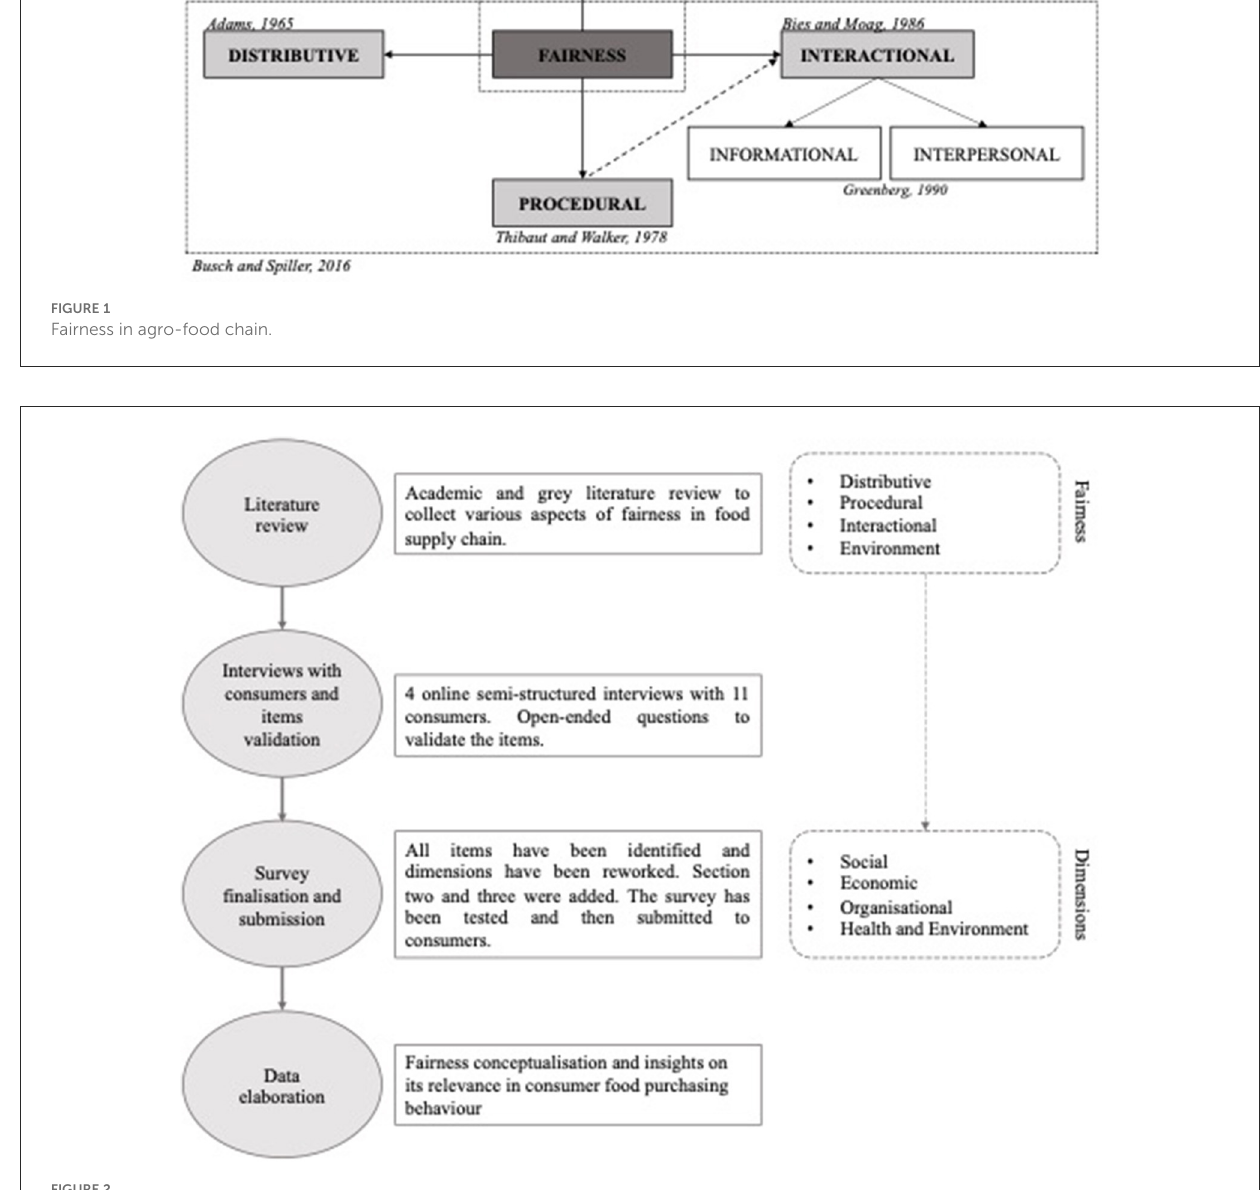
FIGURE2 Methodological framework of the